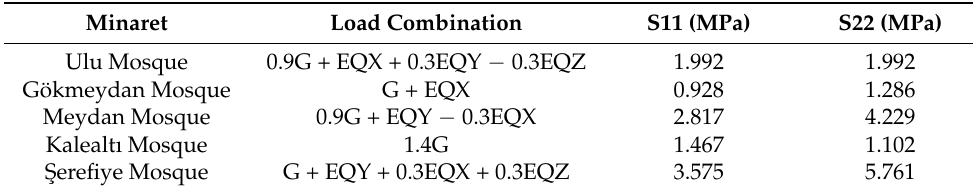
Table 6. Comparison of the maximum tensile stresses obtained for Five Minarets.